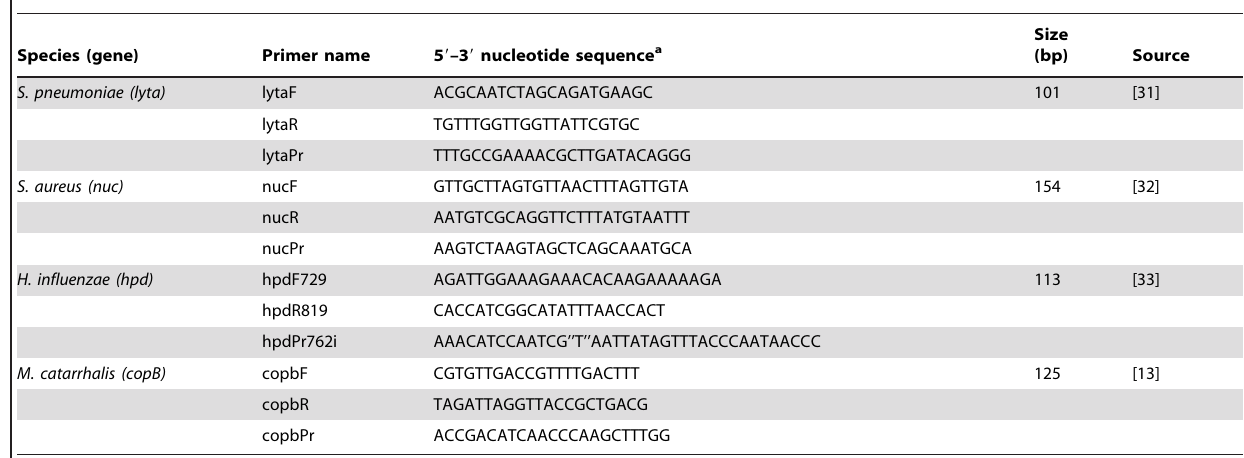
Table 1. Primers and probes used for qPCR assays.